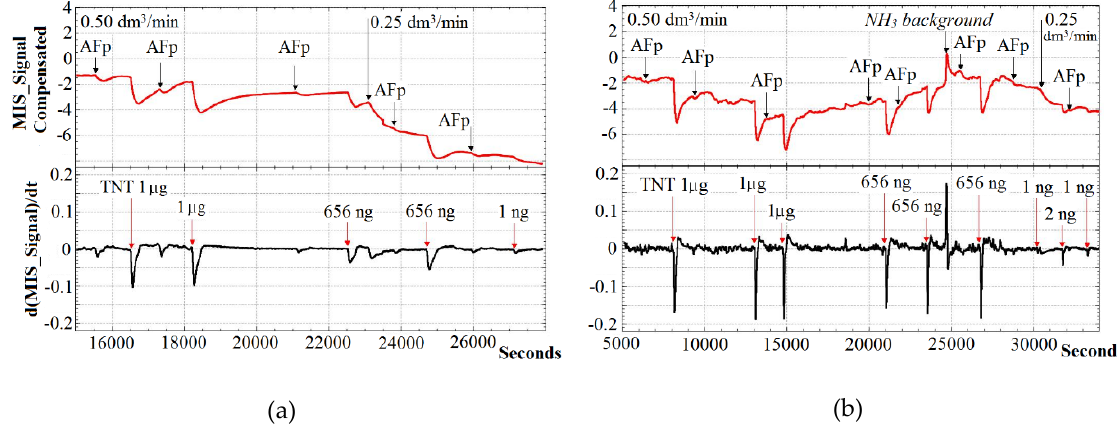
Figure 6. The response of the detector prototype to TNT samples. Working in trace analysis mode with a toaster ‐ type sample preparation module ( a ). Working in the vapor analysis mode with a sample preparation module like a tube ( b ). Designation ʺ AFp ʺ means pure aluminum foil.